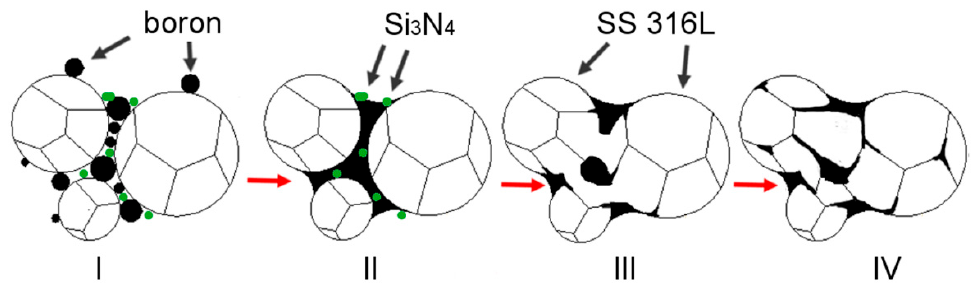
Figure 14. Proposed explanation for microstructural phenomena occurring during the sintering process of boron-doped samples with of silicon nitride addition. I : Mixed state; II : Eutectic liquid creation and primary reorganization; III : Reaction between silicon nitride and boron resulting in the creation of enhanced interconnections among the particles; IV : Penetration of the grain boundaries with retained secondary reorganization.